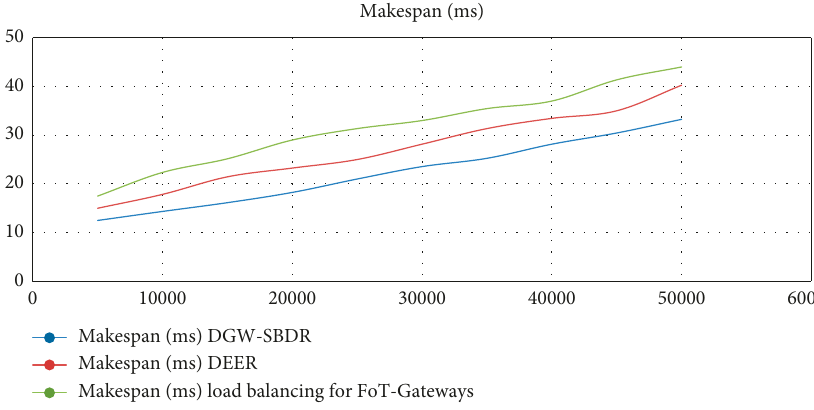
Figure 5: Average makespan of various